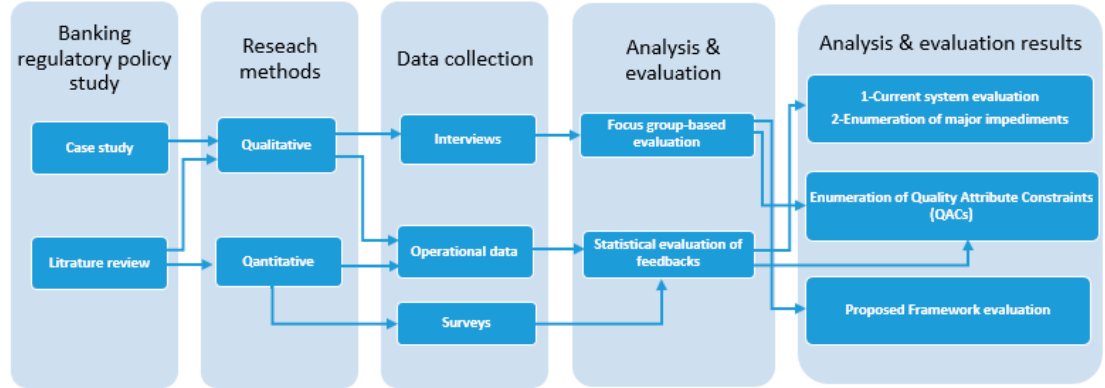
Figure A6. Research Design Chart.